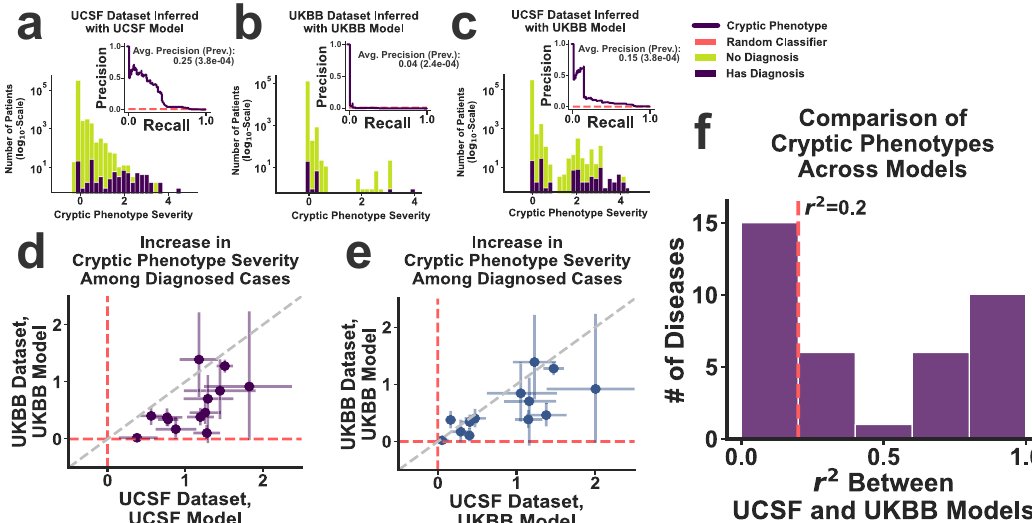
Fig. 2 Cryptic phenotype inference in the UCSF and UKBB datasets. a Distribution of HHT cryptic phenotype severity among the subjects in the UCSF testing dataset, strati fi ed by their HHT diagnostic status (green: controls; purple: HHT cases). a (inset) Precision-recall curve for the prediction of HHT diagnoses using the cryptic phenotype. The approximate performance of a random classi fi er is shown in red. Panel b displays the same information for the UKBB dataset, which was generated using an independently inferred phenotype model. Panel c displays the same information as ( a ), except that the UKBB phenotype model is used to generate the cryptic phenotypes in the UCSF dataset. d , e The increase in cryptic phenotype severity among diagnosed cases is displayed jointly for the UCSF and UKBB models/datasets ( N = 13 diseases, see main text and Supplementary Data 4). Panel d compares the results of the UCSF model (applied to the UCSF dataset; x -axis) with those generated by the UKBB model (applied to the UKBB dataset; y -axis). Panel e instead compares the results of the UKBB model after applying it to both the UCSF ( x -axis) and UKBB ( y -axis) datasets. Error bars in panels d and e represent 95% con fi dence intervals for the severity statistics (estimated using bootstrapped re-sampling, N = 10 5 ). Panel f Coef fi cients of determination ( r 2 ) among the cryptic phenotypes inferred by the UCSF and UKBB models were estimated using the UCSF dataset. The resulting distribution over this statistic is displayed for the 38 diseases where model fi tting was successful in both datasets.